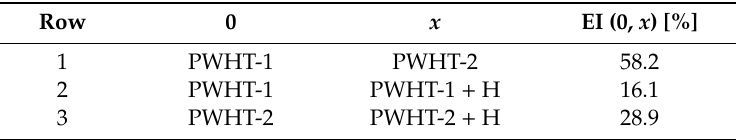
Table 2. Embrittlement index for individual material states.